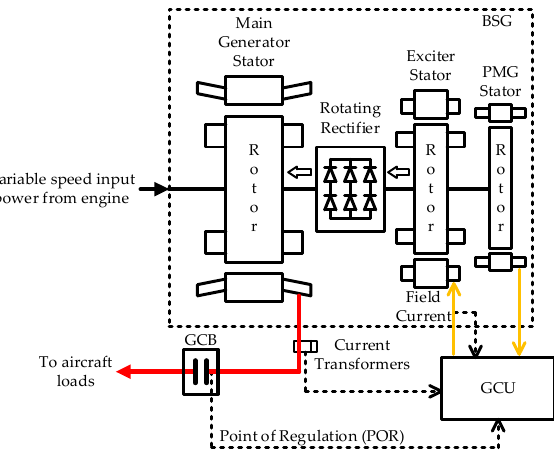
Figure 1. Generator system schematic.